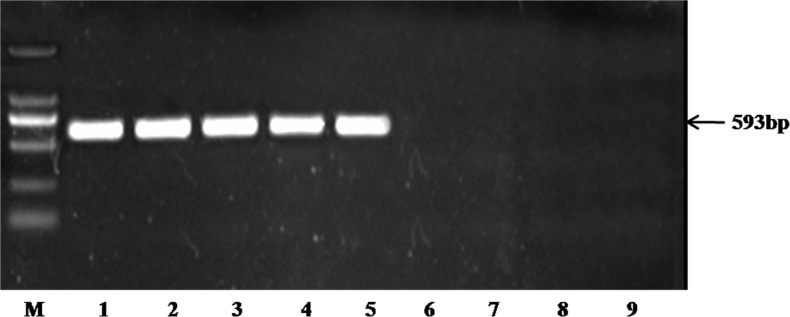
PCR detection of the NIb8 gene in dwarf male-sterile wheat (DMSW) seeding.M, DNA marker; lane1, positive control (N12-1); lanes 2–5, genetically modified (GM) seedling with the NIb8 gene; lanes 6–8, nongenetically modified (non-GM) seedling; lane 9, negative control (H2O).